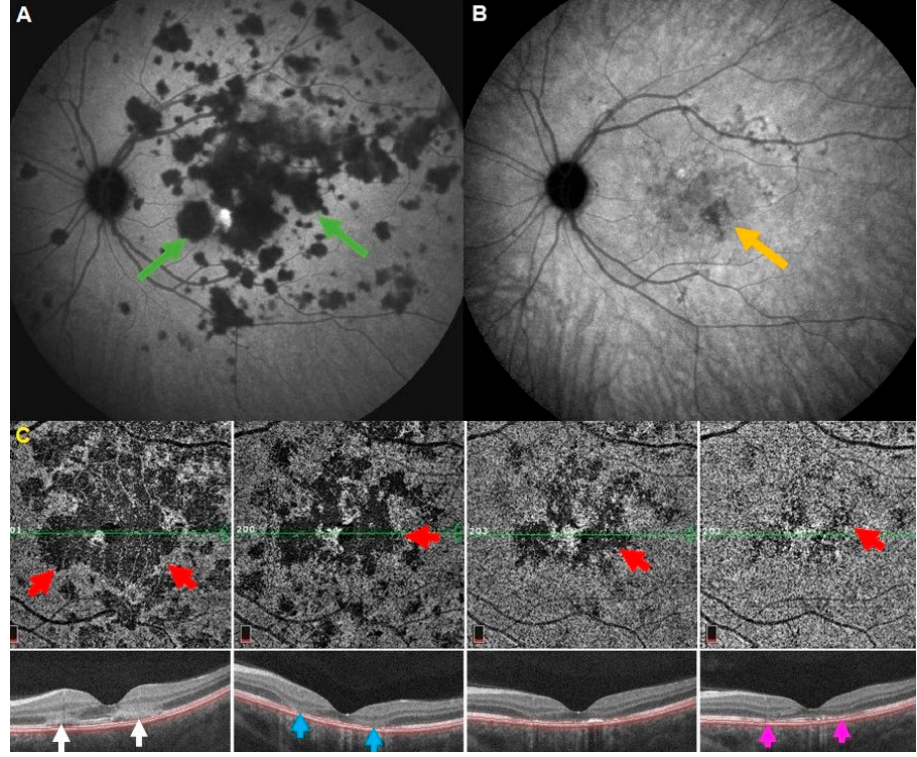
Figure 4. Imaging of a patient with APMPPE, ICGA vs. OCT-A. ( A ), Late frame of ICGA at presen-